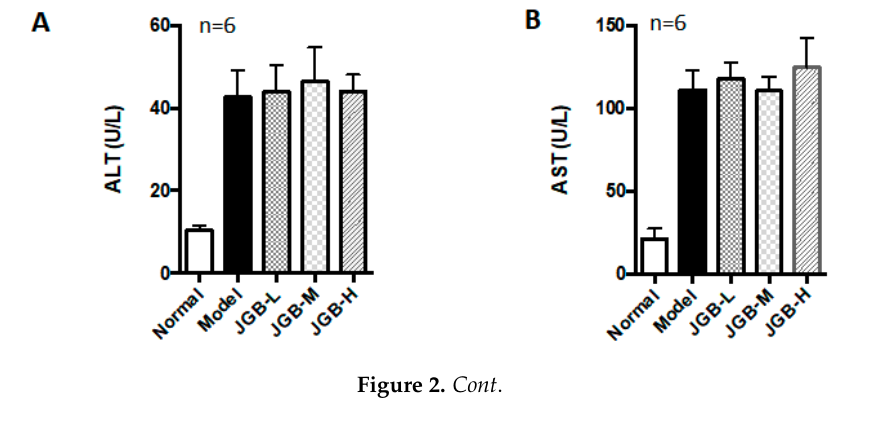
Figure 1. The preventive effect of Jian-Gan-Bao (JGB) on acute alcoholic liver disease (ALD). ( A ) Serum alanine aminotransferase (ALT) levels of mice from different groups; ( B ) Serum aspartate aminotransferase (AST) levels of mice from different groups; ( C ) Hematoxylin and eosin (H&E) staining images and scoring of liver histology of mice from different groups; ( D ) Malondialdehyde (MDA) levels in liver of mice from different groups; ( E ) Superoxide dismutase (SOD) levels in liver of mice from different groups; ( F ) Catalase (CAT) levels in liver of mice from different groups; ( G ) Glutathione peroxidase (GSH-Px) levels in liver of mice from different groups. (JGB-L: JGB-low dose group, JGB-M: JGB-middle group, JGB-H: JGB-high group). Three biological replicates were performed for each study. * p < 0.05, ** p < 0.01, when compared with model group.